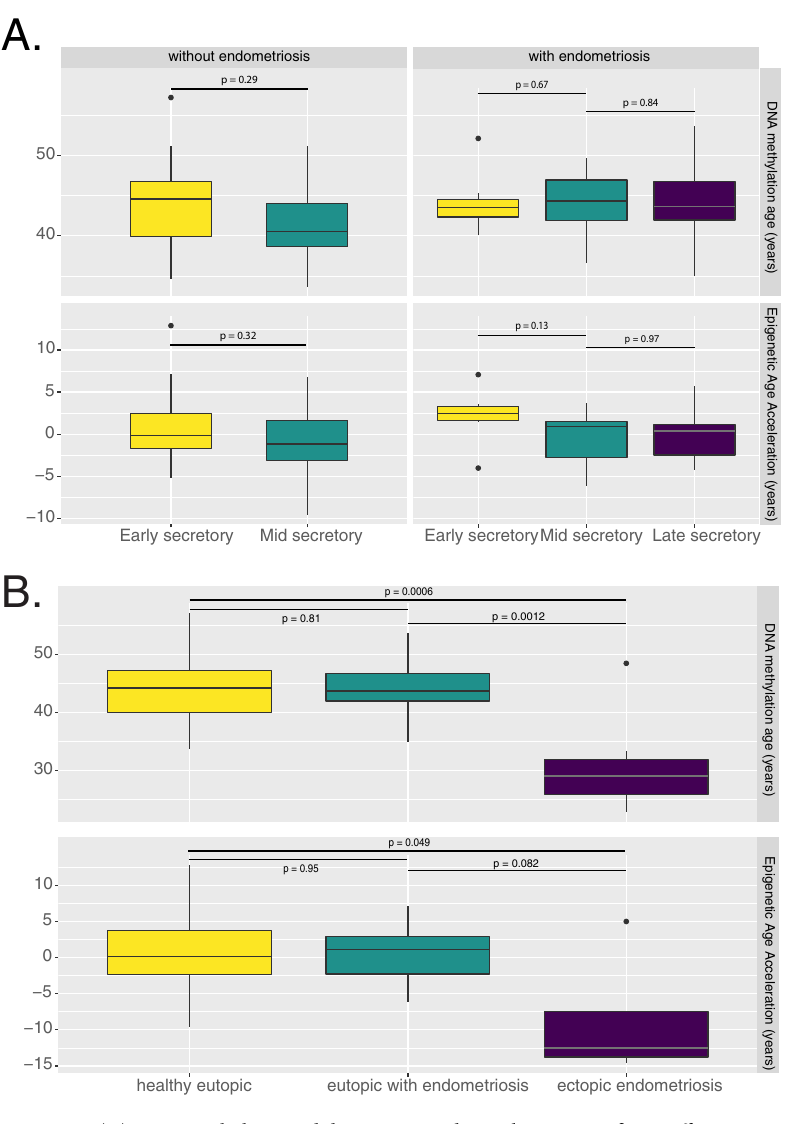
Figure 2. ( A ) Menstrual phase and disease status do not have a significant effect on DNA methylation age (top) or Epigenetic Age Acceleration (bottom). All samples are of eutopic tissue, coming from 26 women with endometriosis (early secretory: n = 7, mid secretory: n = 10, late secretory: n = 9) and 17 women without endometriosis who each donated samples at early- and mid-secretory phases of the same menstrual cycle. P values for paired comparisons using the Wilcoxon rank sum test are included. ( B ) Ectopic endometriotic lesions are significantly younger than eutopic samples as seen in the boxplot; midline is the median, box edges represent the interquartile range. Healthy eutopic: n = 42; eutopic with endometriosis: n = 29; ectopic endometriosis: n =